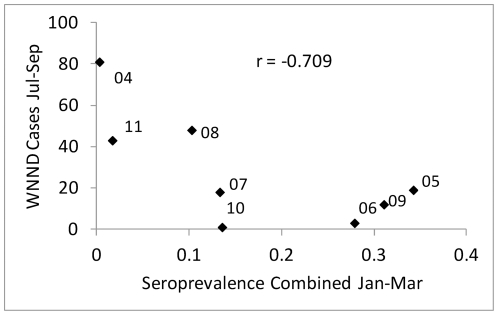
West Nile neuroinvasive disease (WNND) cases during July–September plotted as a function of combined antecedent House Finch and House Sparrow seroprevalence during January–March for each year from 2003–2011.Values were inversely correlated (r, P<0.05).